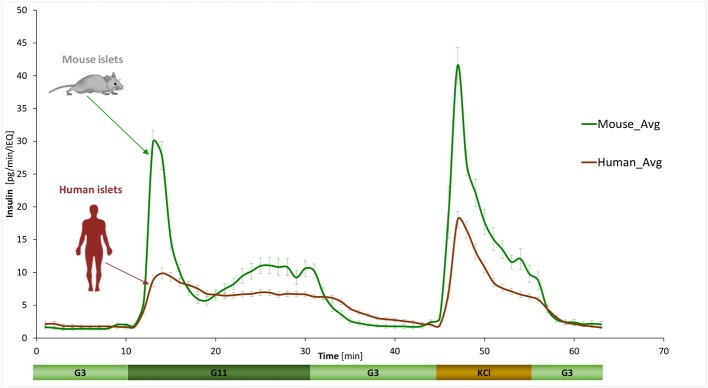
Dynamic GSIS in isolated human and murine islets. Average of all experimental data collected for free murine and human islets perifused using a low (3 mM; G3, 8 min) → high (11 mM; G11, 20 min) → low (3 mM; G3, 15 min) incoming glucose stimulation (plus 10 min KCl followed by G3) as shown. Automated PERI4-02 multichannel perifusion apparatus used (samples collected every minute; 0.1 mL/min flow rate, ~100 IEQ per channel). Data are average ± SEM from multiple isolations (n = 25 and 34 total samples for murine and human, respectively).